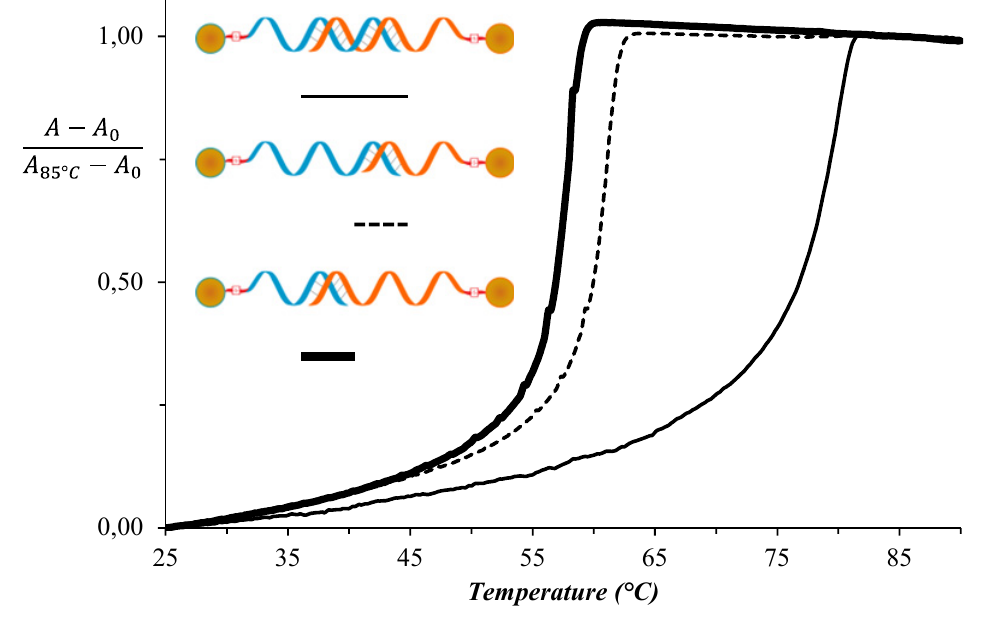
Figure A5. Normalized absorbance at 260 nm during the assembly of DNA-AuNPs functionalized with the complementary strands T10-DNAA T10 DNAA & T10-DNAT (dotted), and T10 DNAA 11 5 function of